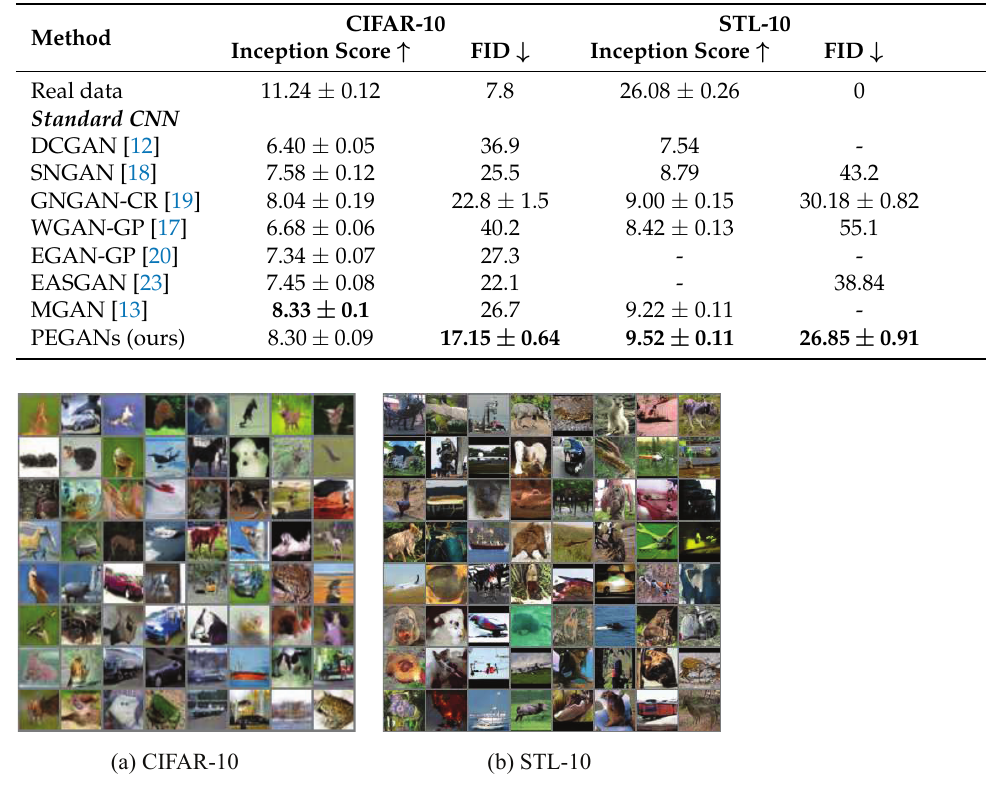
Figure 4. Samples randomly generated by our PEGANs (not cherry-picked).